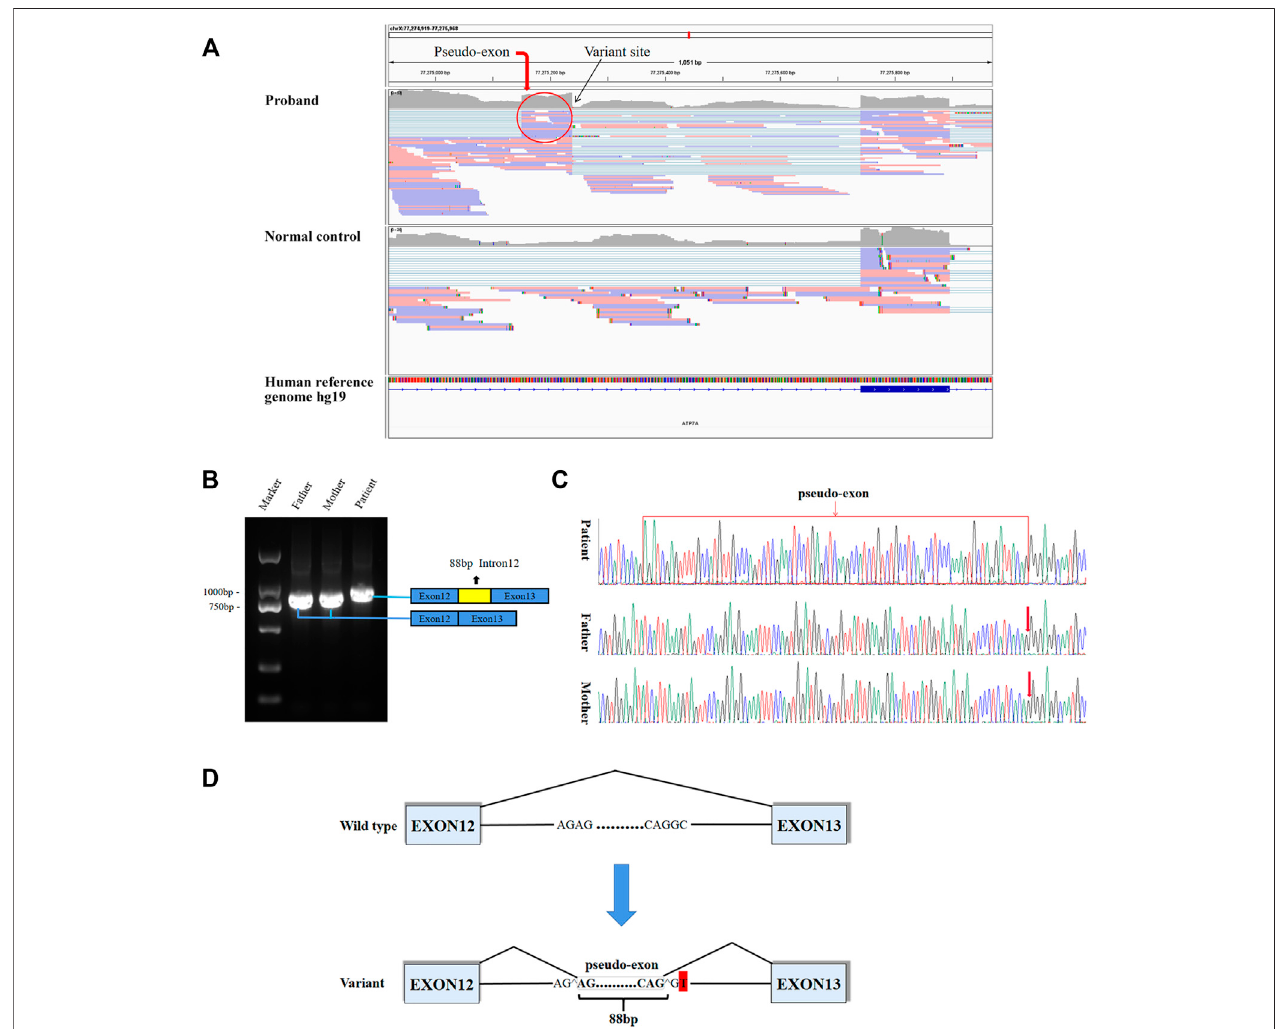
FIGURE 2 | Aberrant splicing caused by the varant. (A) RNA-seq demonstrated an abnormal splicing pattern that resulted in an out-of-frame pseudo-exon between exons 12 and 13. The black arrow pointed to the variant site, and the red circle was the fragment from intron 12 inserted between exons 12 and 13. (B) In agarosegelelectrophoresisofRT-PCR,alagerproductsizeinpatientcompared withthenormalsizeofhisparents.Theblueboxesrepresentedexons,andtheredbox representedintronfragmentinsertedbetweenexons12and13. (C) ThesequencingresultsofRT-PCRshowedtherewasa88bppseudo-exonfragmentbetween exons 12 and 13 in mature ATP7A mRNA of the patient compared to his normal parents. (D) Schematic diagram of WT and variant splicing patterns showed that the variantsitecreatedanew5 ′ donorsplicesiteandactivatedtheupstream3 ′ acceptorsplicesiteconcomitantly,therebycreatingtheaberrantsplicing.Boxesrepresented exons. Straight lines represented base sequences. Broken lines represented splicing